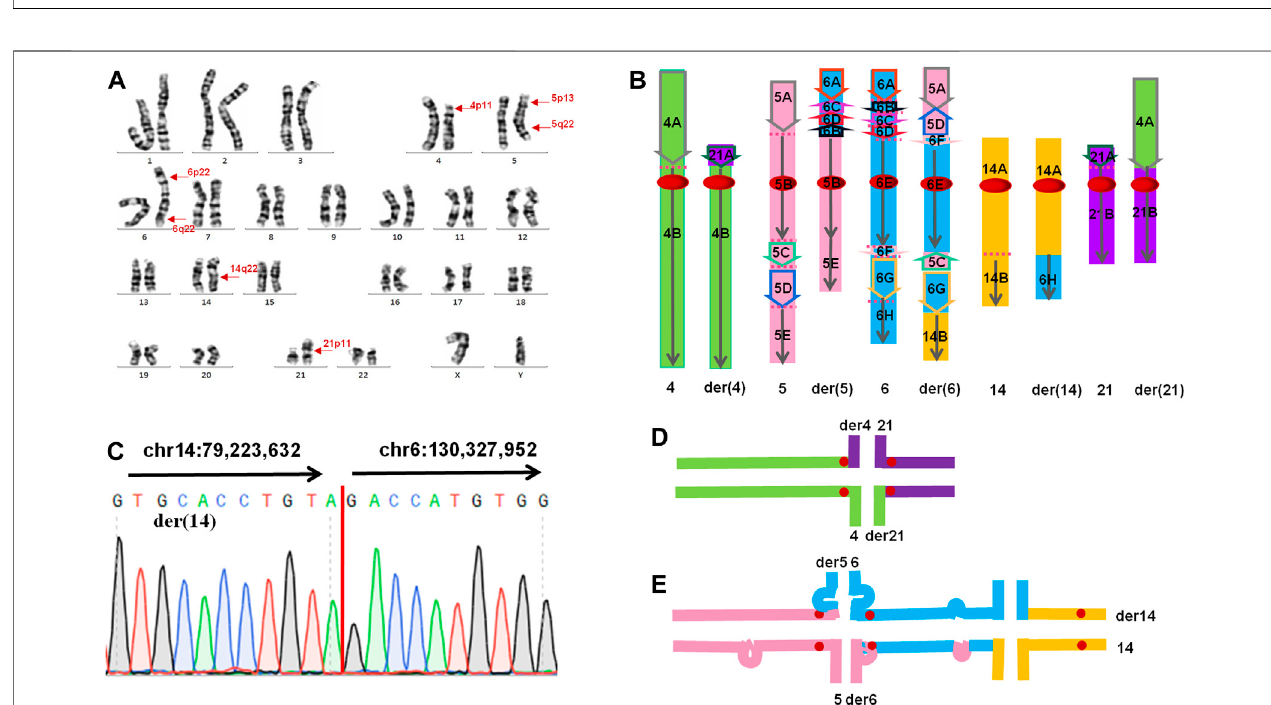
FIGURE 2 | (A) The karyotype result of the patient. Arrows indicate the breakpoints. (B) The presumed pattern of variation of involved chromosomes in this CCR. The green colour represents chromosome 4, the pink colour represents chromosome 5, the blue colour represents chromosome 6, the orange colour represents chromosome 14, and the purple colour represents chromosome 21. (C) Sanger sequencing result on der(14). The translocation breakpoints (red line) detected by nanopore sequencing were con fi rmed by Sanger sequencing. Sequence directions from different chromosomes were indicated by arrows. (D,E) Putative chromosomepairingbycomplexchromosomalrearrangementduringthepachytenestageofmeiosis. (D) Schematicviewofaquadrivalentcon fi guration. (E) Schematic view of a hexavalent con fi guration. Substantial portions of the asynaptic regions in the hexavalent con fi guration mainly contain insertion and inversion.